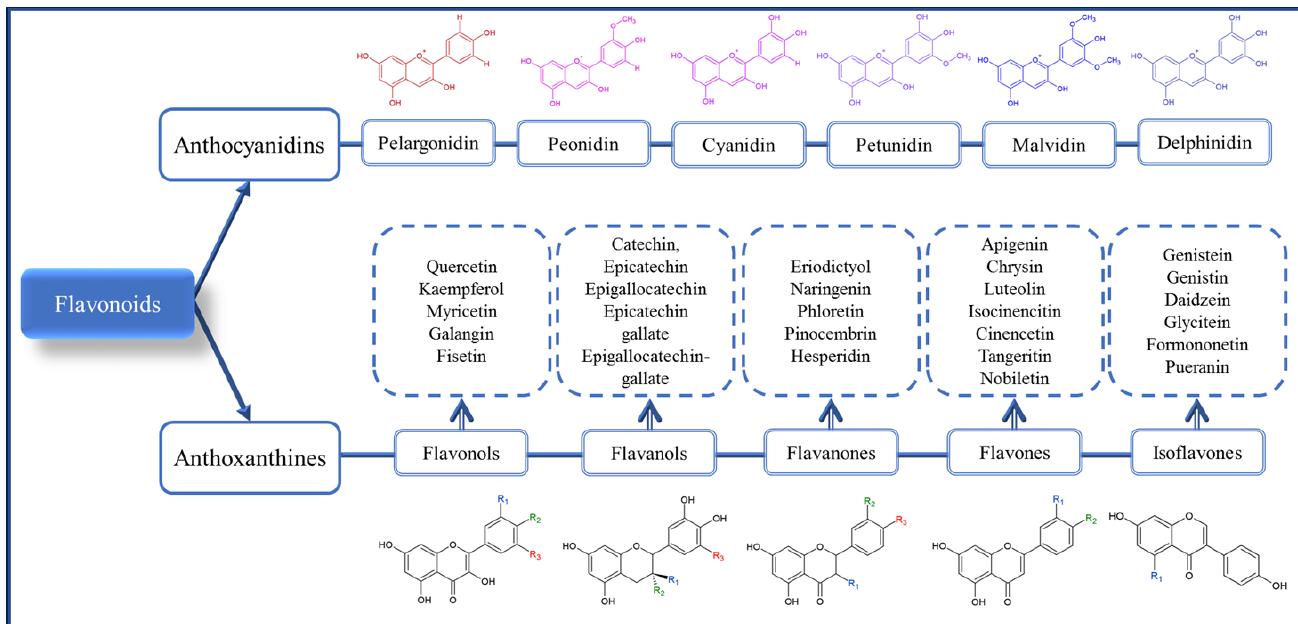
Figure 1. Chemical structure of main phenolic acids found in cereals and pseudocereals.